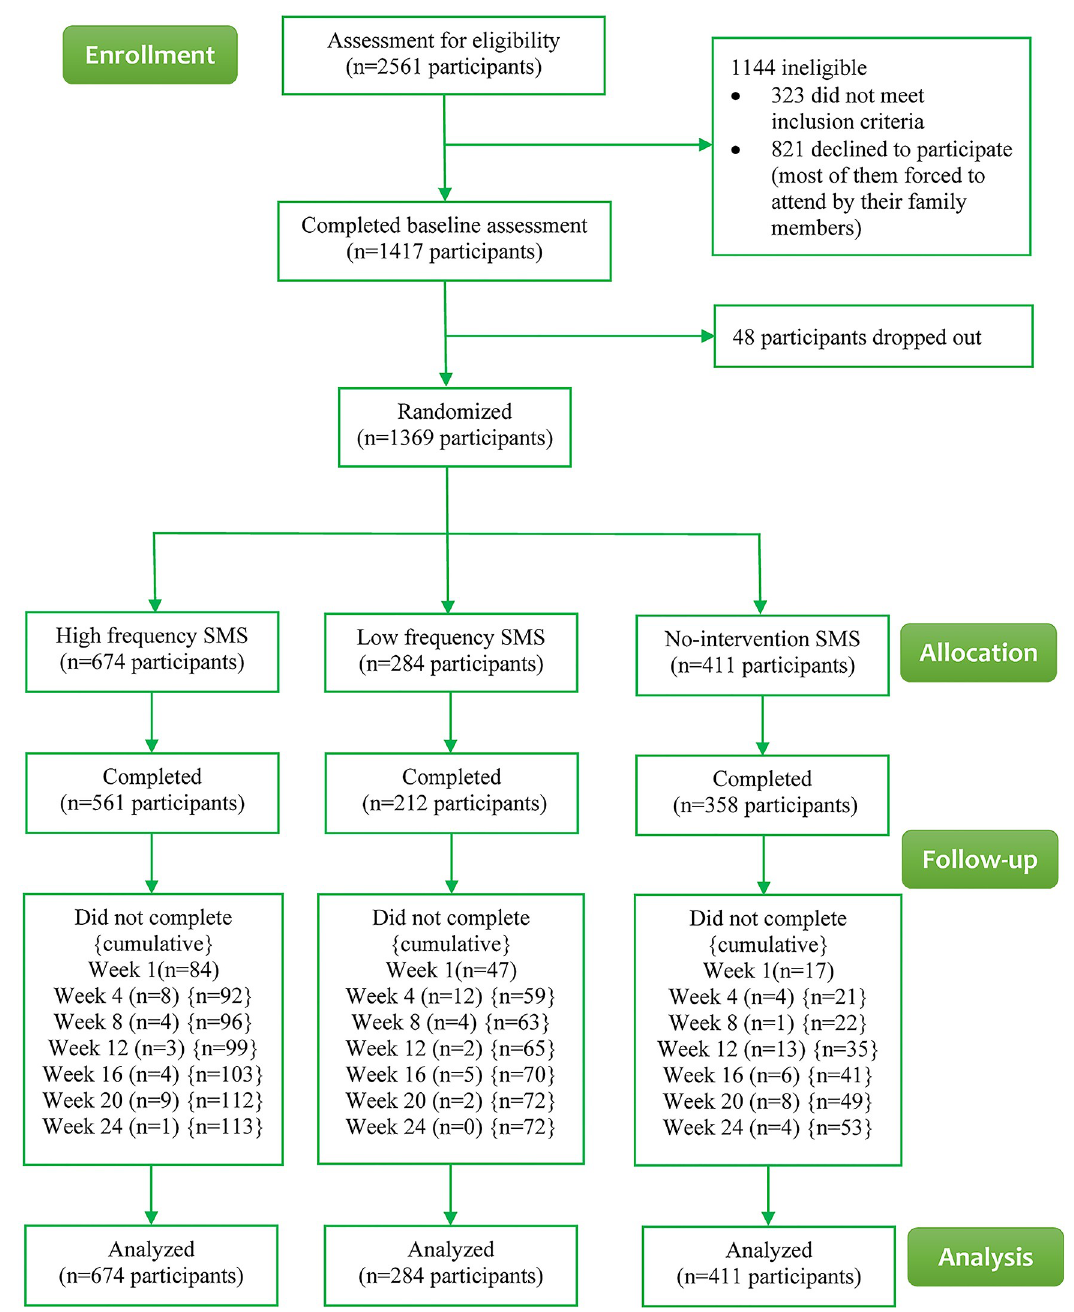
Fig 1. Flowchart of participants. SMS, short message